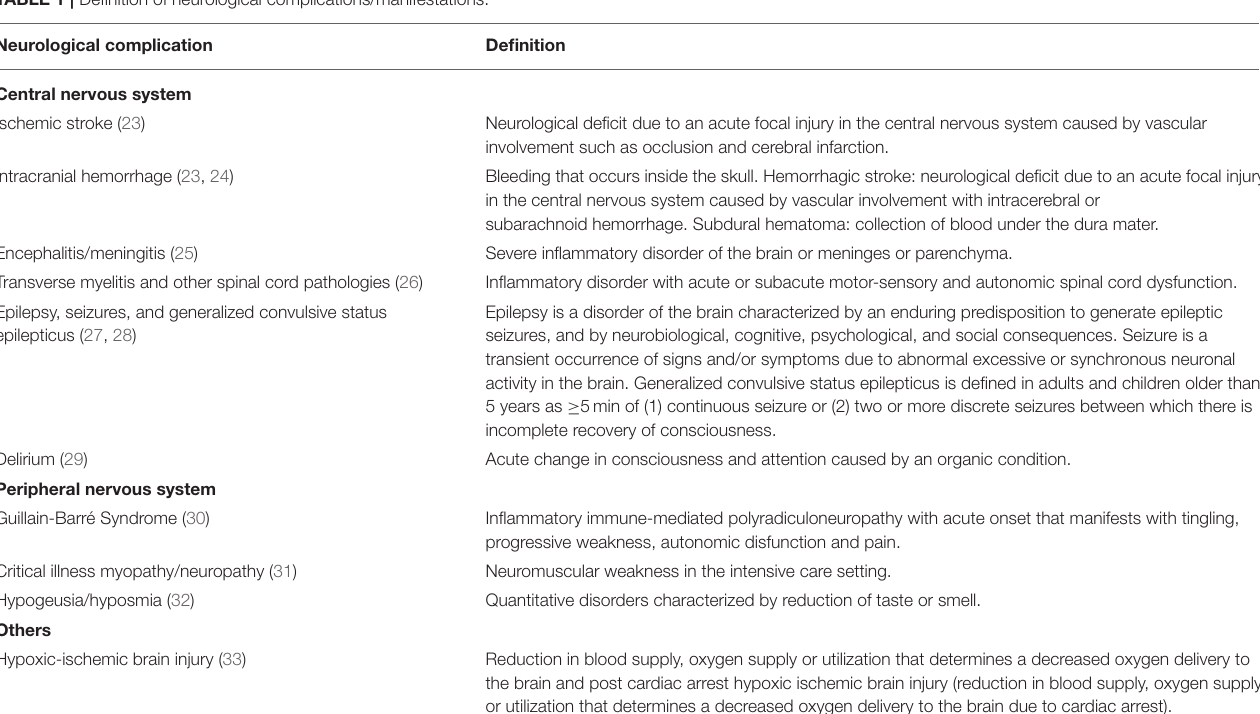
TABLE 1 | Definition of neurological